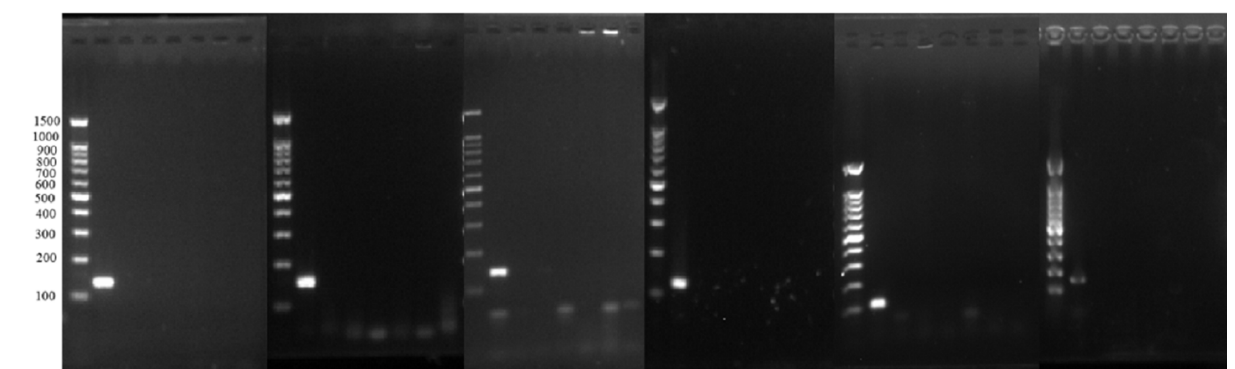
Figure 2. Primer specificity validation. From left to right, the primers in the 6 electropherograms are LA, LB, LC, LD, LF, and ST. The DNA templates in the first well of each electropherogram are LA, LB, LC, LD, LF, and ST, and the last well is a negative control. The DNA templates in the remaining five wells are the remaining five strains of LAB DNA except for the first well.